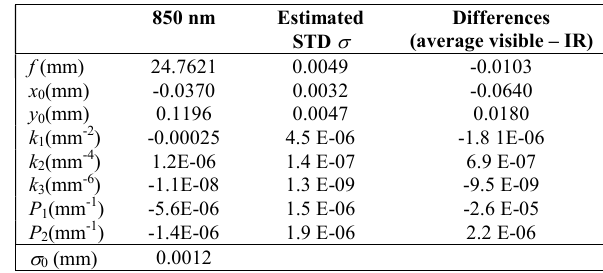
Table 5. Results obtained with the automatically cropped images: estimated values for the IOPs of images of the infrared, estimated standard deviations and differences with respect to the average value of visible